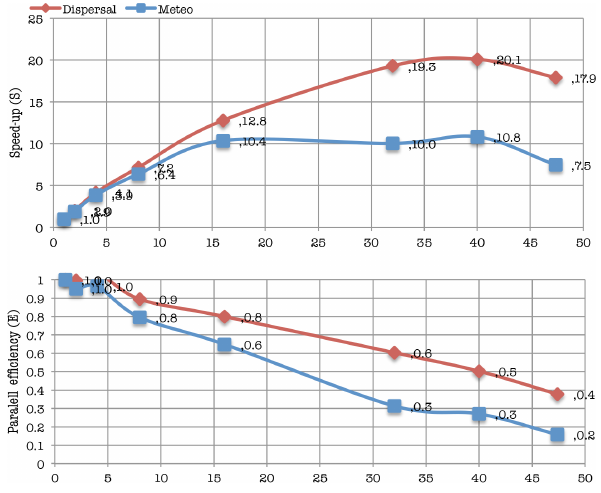
Figure 12. NMMB-MONARCH-ASH scalability results. Top panel: parallel speed-up ( S , computational speed) for meteorology only (blue) and for meteorology and dispersal combined (red). Bot- tom panel: parallel efficiency ( E ) vs. number of computation nodes